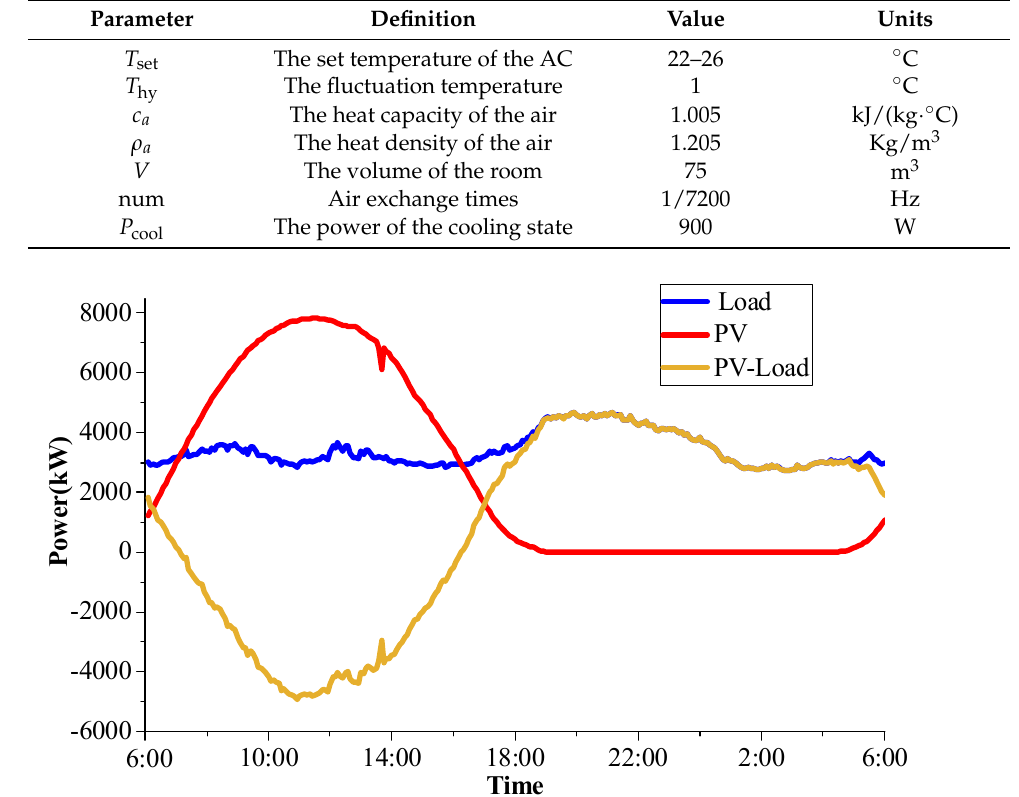
Figure 8. Aggregated data of photovoltaics (PVs) and base load. Table 1. The parameters of the AC model and the thermal model.